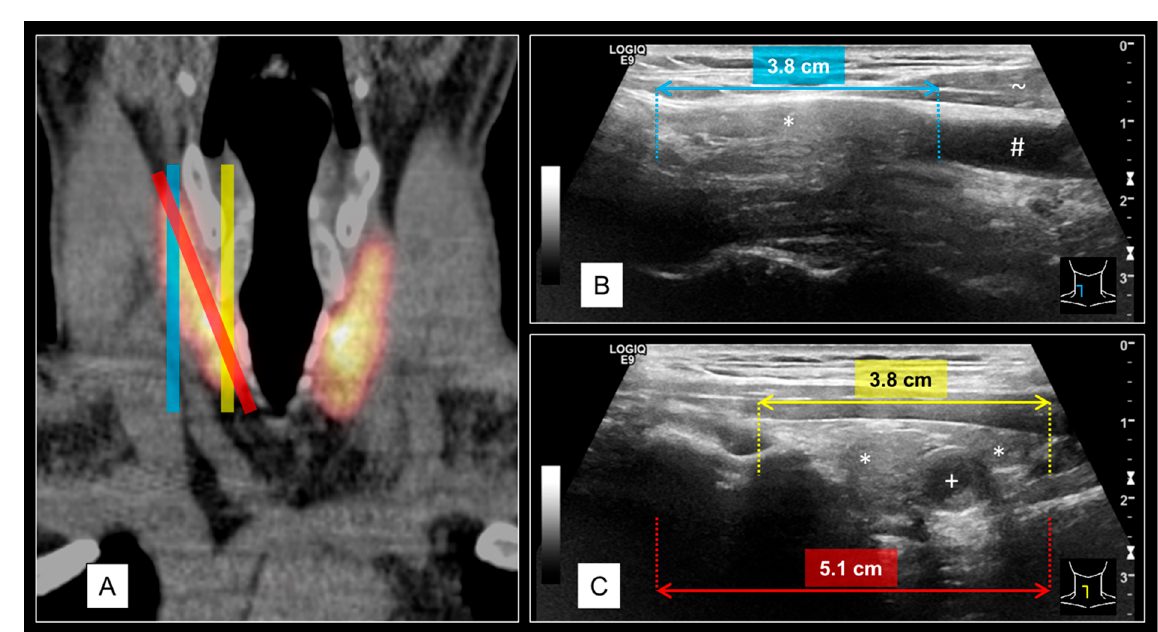
Figure 4. Schematic illustration of a potential error source for retrospective thyroid volume determinations on MTA US cine loops. The example shows a normal-sized right thyroid lobe (11 mL) of a 50-year-old male. The vertical expansion of the thyroid gland is not exactly upright in most humans ( A ), coronal orientated I-124-PET/CT image of the thyroid). A slight angle of the US probe is necessary to cover the whole extent of the thyroid lobe in sagittal orientation (red stripes on A , C ). In case of strict vertical positioning of the US probe, the lateral image may miss the caudal pole (blue stripes on A , B ) whereas the medial image misses the cranial pole (yellow stripes on A , C ). Labels: * thyroid tissue, + thyroid nodules (TN), # carotid artery, ~ muscle tissue.